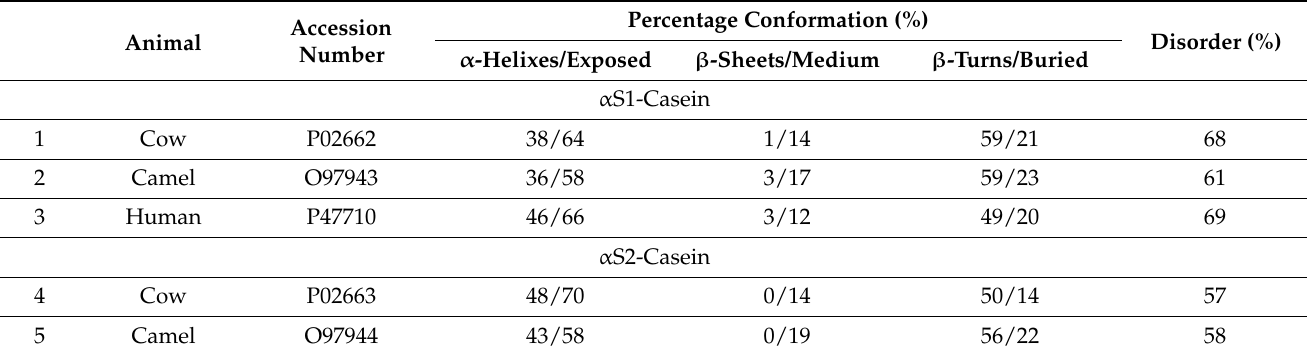
Table 4. The percentages of α -helixes, β -sheets, coils, and disordered residues in α s1-, α s2-, β - and κ -caseins of the studied animals (%)